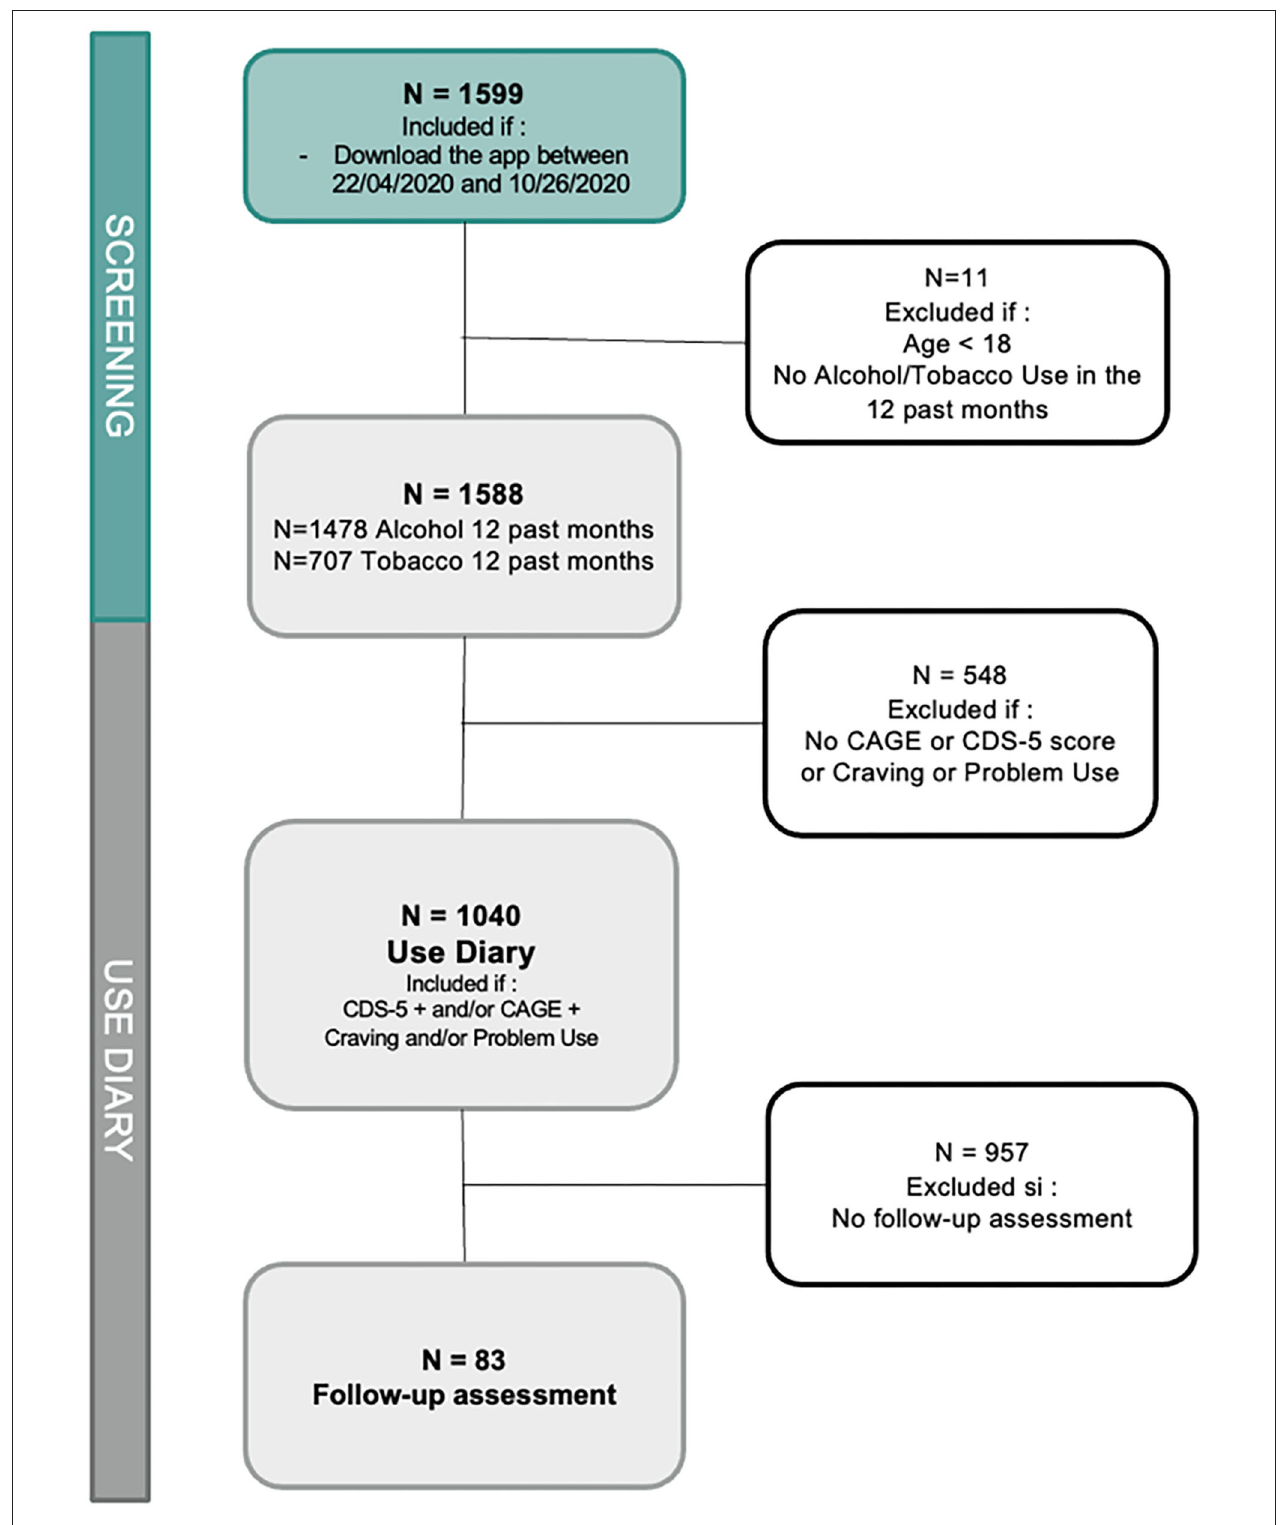
FIGURE 1 | Flowchart of users included in the different steps of analyses.